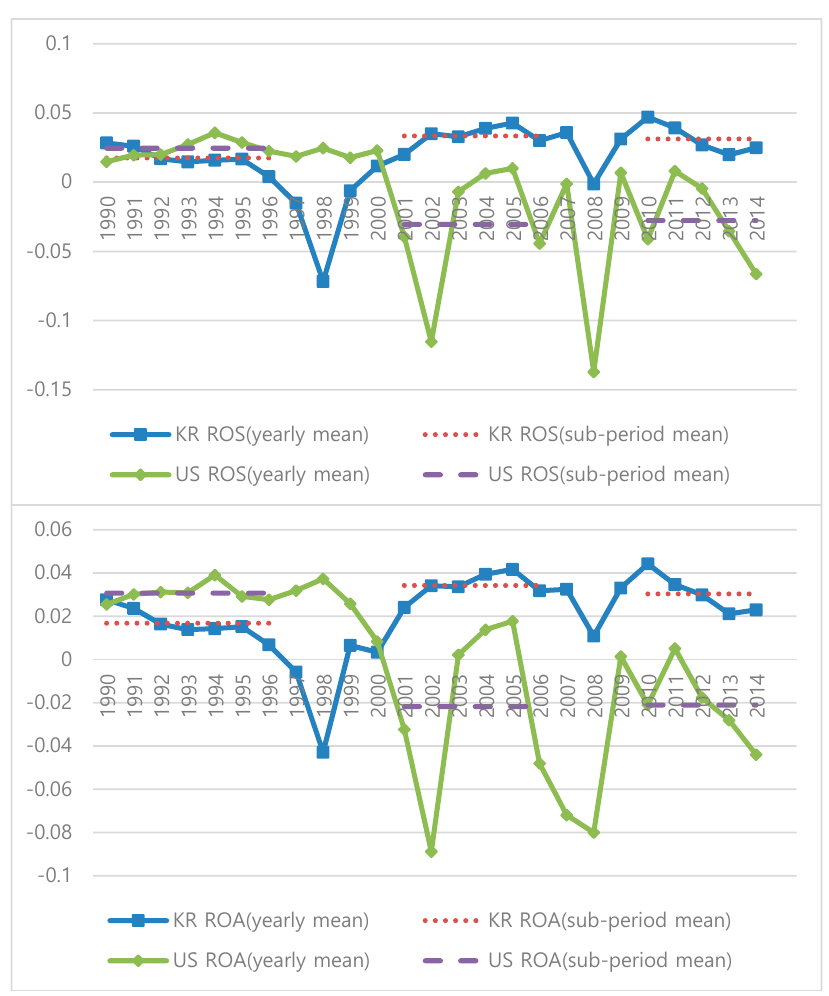
Figure 4. Comparison of profitability (ROS, ROA). Table 5. Comparison of profitability (ROS, ROA) by regression.